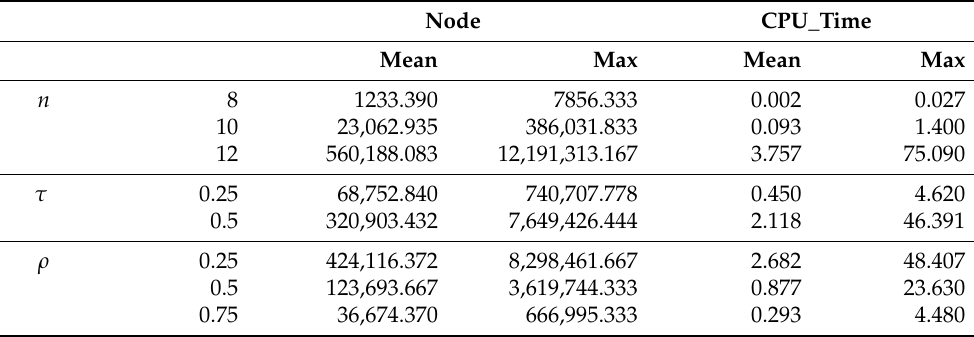
Table 2. Summary of the results of the B&B